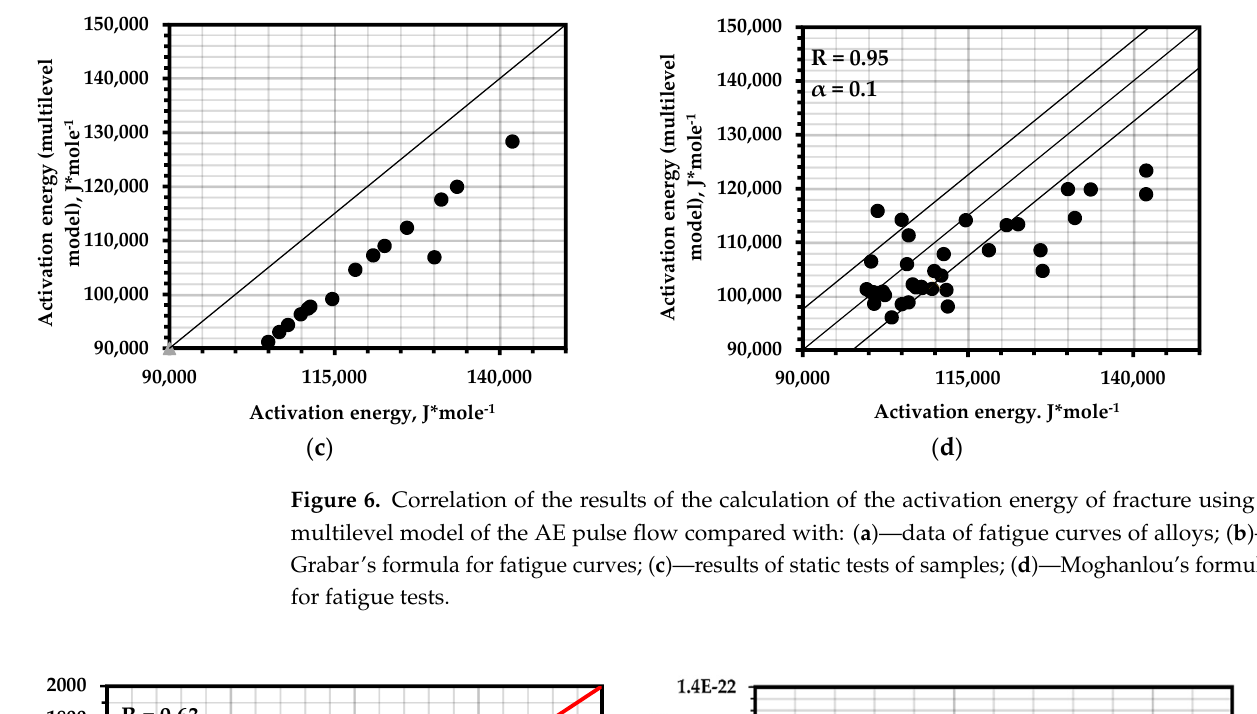
Figure 6. Correlation of the results of the calculation of the activation energy of fracture using a multilevel model of the AE pulse flow compared with: ( a )—data of fatigue curves of alloys; ( b )— Grabar’s formula for fatigue curves; ( c )—results of static tests of samples; ( d )—Moghanlou’s for- mula for fatigue tests.